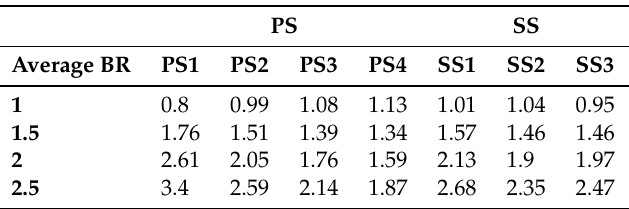
Table 2. Row-by-row values of